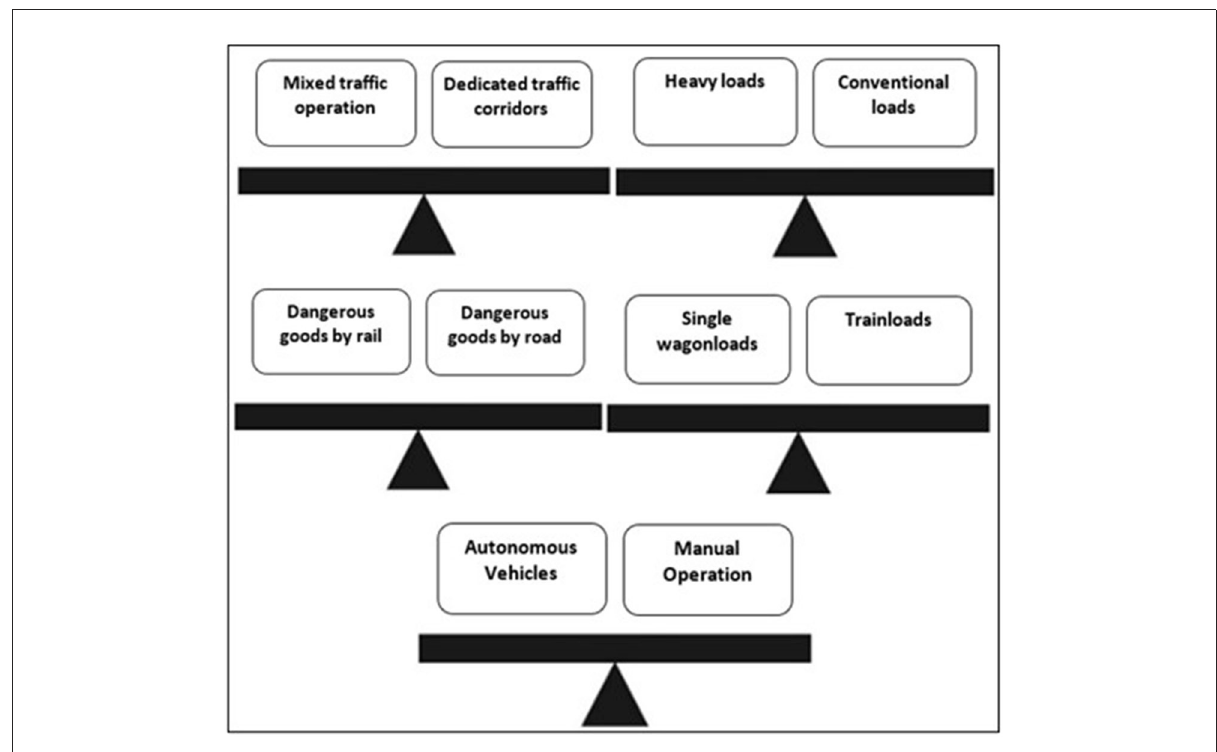
FIGURE1 The main “dilemmas” for rail freight players (author